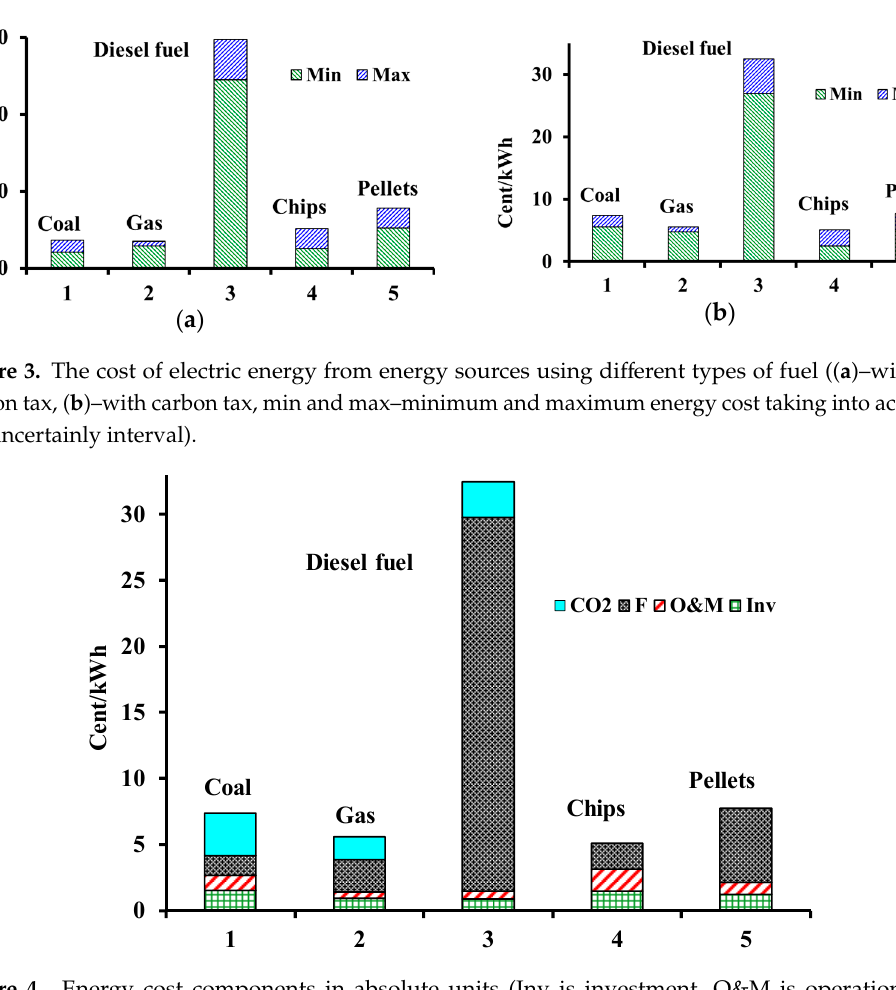
Figure 5. Energy cost components in relative units (Inv is investment, O&M is operation and maintenance, F is fuel, CO 2 associated with the payment for carbon dioxide emissions). Calculations show that the cost of electricity mini-CHP on wood fuel (wood chips) is significantly less than the cost of electricity of a diesel power plant. In this regard, for autonomous energy systems of small power, especially near the logging points, energy supply from gasification- based mini-CHP on biomass is more preferable than the use of diesel plants with a predominance of the fuel component in the energy cost. Compared to coal and gas power plants, wood-fired mini-CHPs can be both more and less efficient, depending on specific conditions. If there is no charge for carbon dioxide emissions, then wood-based energy sources are on average inferior to competing mini-CHP plants on coal and gas, except for the option of using cheap fuel chips at a price of $ 30–40/toe (see Figure 3a). With the introduction of an emission charge of $ 30/t CO 2 , the competitiveness area of wood- fired power plants expands. In this case, wood firing mini-CHP plants on wood chips are more efficient than coal-fired and, in some cases, gas-fired power plants (see Figure 3b). This is because the